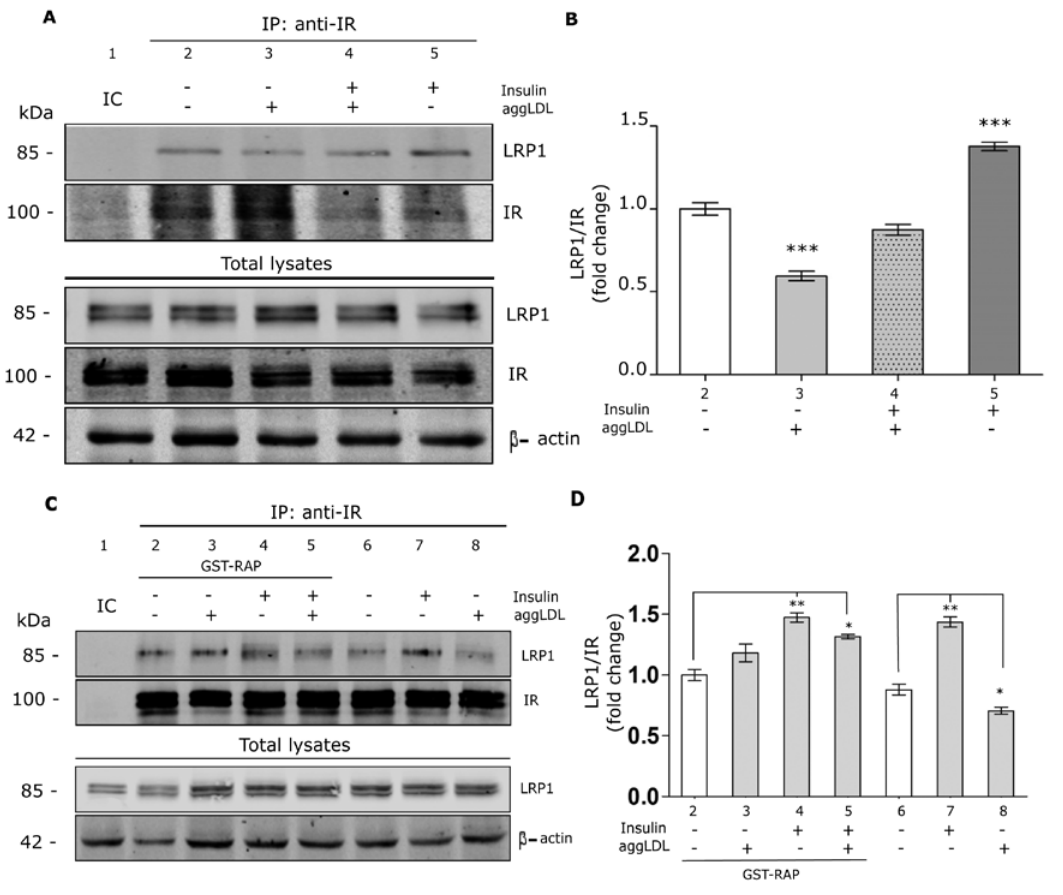
Figure 3. Molecular association between IR and LRP1 in aggLDL-treated HL-1 cells. ( A ) Immunoprecipitation assay for IR. Cell lysate was immunoprecipitated with an anti-IR antibody and then subjected to SDS-PAGE and followed by Western blot assays for LRP1 and total IR. Cells were incubated or not with 100 µ g / mL aggLDL for 8 h and then stimulated or not with 100 nM insulin for 30 min. Lane 1, immunoglobulin isotype control (IC). The detection of LRP1, IR and β -actin in total cell lysates is shown in the lower panel of the Western blot. ( B ) The bar graph represents the densitometric quantification of the bands obtained in the Western blot. Values were expressed as the mean ± SEM of the relative intensity of LRP1 bands with respect to IR and shown as a fold change against control (white bar). (***) indicate significant di ff erences ( p < 0.0001) vs. control. Three independent experiments were performed in duplicate. ( C ) Immunoprecipitation assays for IR followed by Western blot for LRP1 β -subunit. Cells were or not preincubated with 400 nM GST-RAP for 30 min, then incubated or not with 100 µ g / mL aggLDL for 8 h in the presence of 400 nM GST-RAP and subsequently stimulated or not with 100 nM insulin for 30 min. Lane 1, immunoglobulin isotype control (IC). The detection of LRP1 and β -actin in the total cell lysates is shown in the lower panel of the Western blot. ( D ) The bar graph represents the densitometric quantification of the bands obtained in the Western blot. The values were expressed as Mean ± SEM of the relative intensity of LRP1 bands with respect to IR, and reported as fold change against the corresponding control (white bar). (*) ( p < 0.05) and (**) ( p < 0.01) indicate significant di ff erence regarding to controls. Three independent experiments were performed by duplicate.